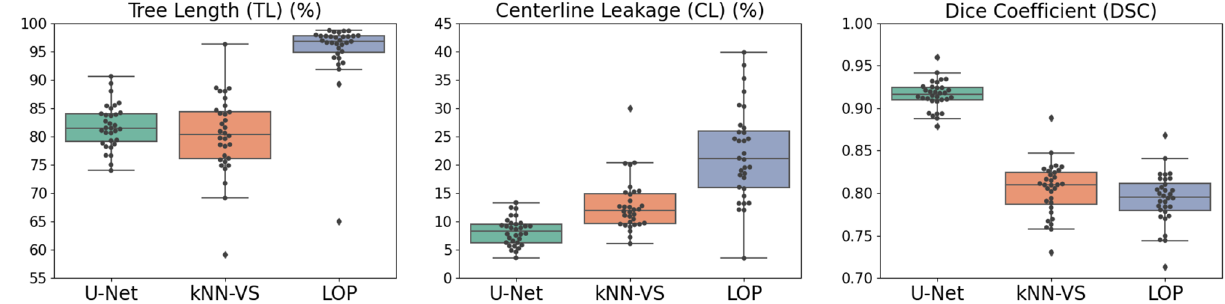
Figure 4. Boxplots showing (1) tree length detected, (2) centerline leakage and (3) Dice coefficient on the DLCST data, for the results obtained by our U-Net-based method and the kNN-VS 9 and LOP 10 methods. For each boxplot, the box shows the quartiles of the data (defined by the median, 25% and 75% percentiles), the whiskers extend to include the data within 1.5 times the interquartile range from the box limits, and the markers show all the data